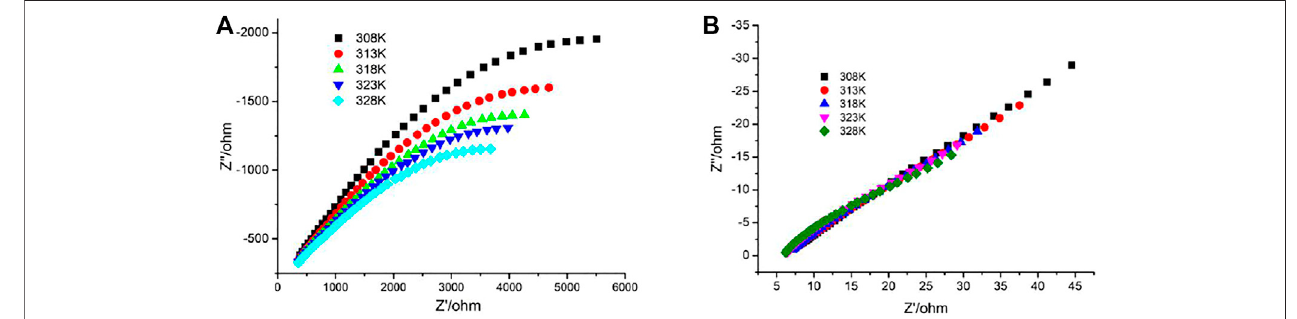
FIGURE 3 | Nyquist plots of 1 at (A) 75% and (B) 99% RH at the selected temperatures.